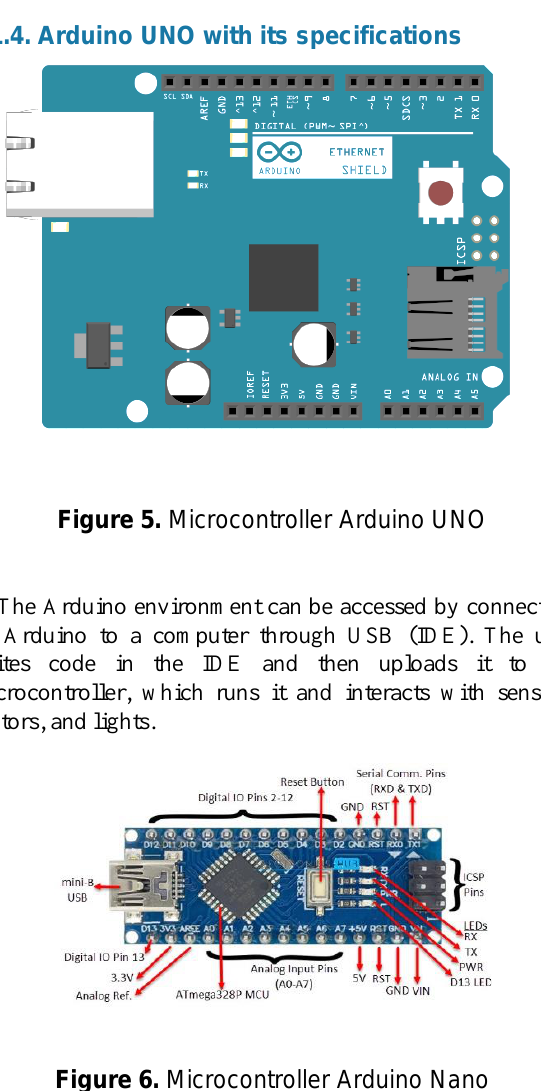
Figure 7. Arduino IDE